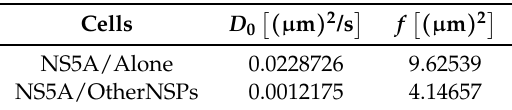
Table A5. Fit parameters in (A1) of linear regression dependency of diffusion constant value on pseudo reaction constant, on ER